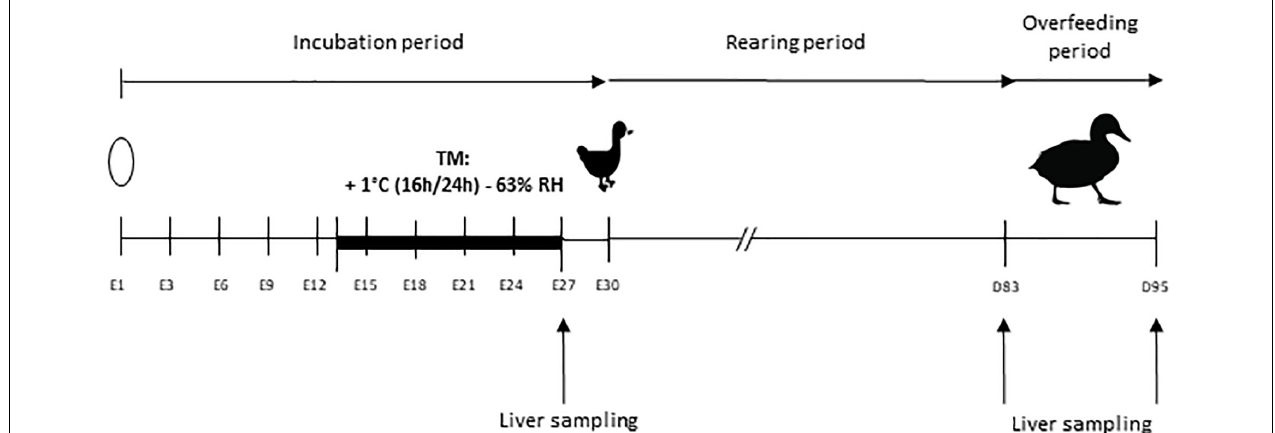
FIGURE 1 | Experimental design. Incubation period extends from embryonic day 1 (E1) to day 30 (E30), day of peak hatching of the ducklings. The thermal manipulation (TM) was performed between E13 and E27, with a temperature increase of 1 ◦ C (16 h/24 h) and relative humidity (RH) adjusted to 63%. Overfeeding began at 83 days of age (D83) and ended at 95 days (D95). Liver samplings for RNA extraction are indicated by an arrow at the end of the TM (E27) and before (D83) and after (D95)